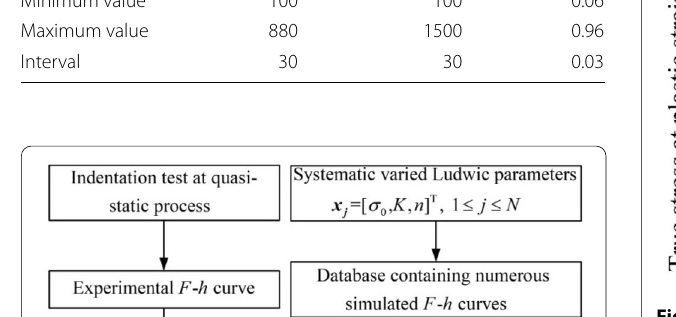
Figure 4 Typical f ( x ) − σ ε σ ε ( x ) with decreasing f ( x i